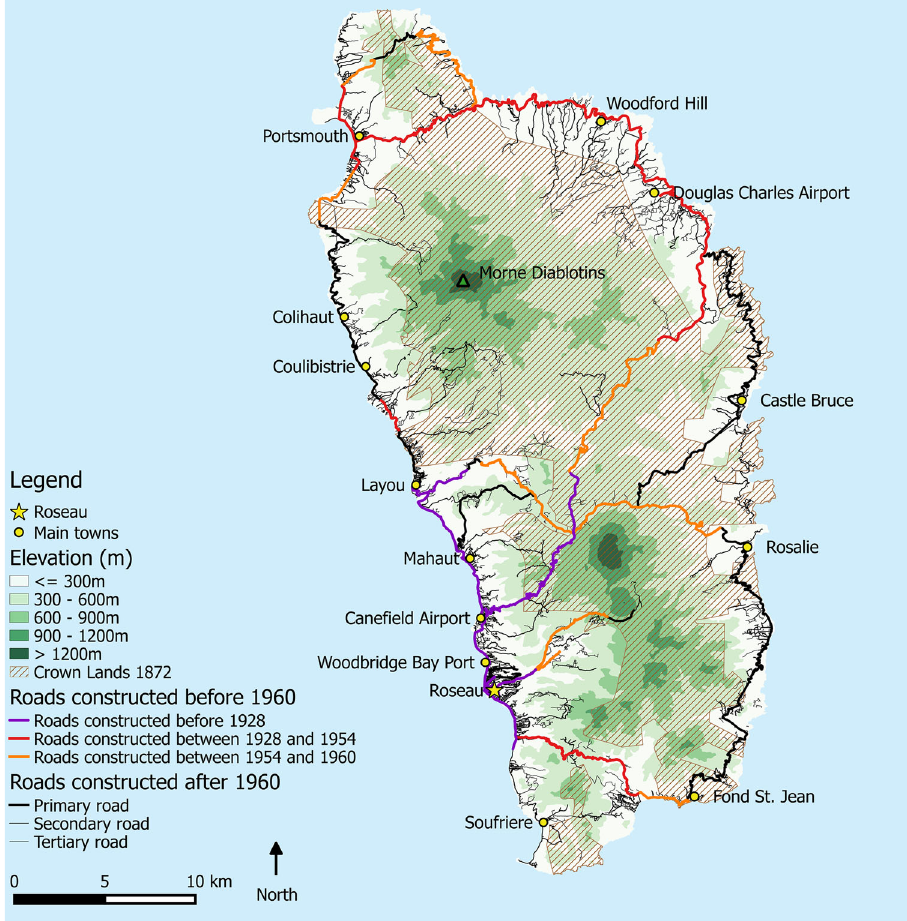
Fig. 1 Topographic map of Dominica showing the capital city Roseau and other selected settlements, ports and airports, and main roads. The ‘‘King’s Three Chains’’ (Table 2) is not shown as it is only 66 yards or 60.35 m wide but follows entire coast. Source Caribbean Handbook on Risk Management (CHARIM) geonode for Dominica (http://charim- geonode.net/) and